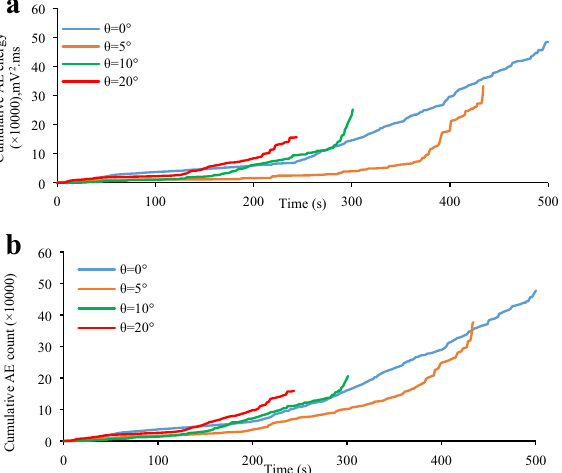
Figure 14. Specimen inclination angle with respect to the cumulative AE count and cumulative AE energy: ( a ) specimen inclination angle with respect to the cumulative AE energy; and ( b ) specimen inclination angle with respect to the cumulative AE